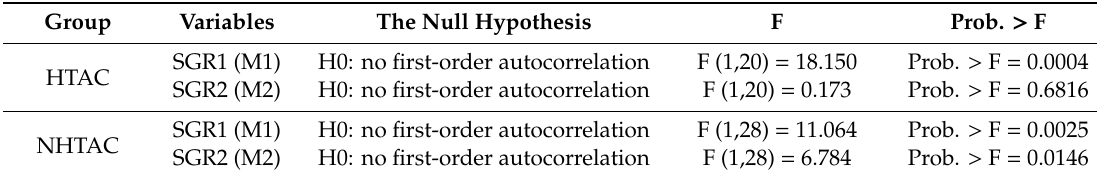
Table 7. Wooldridge test for autocorrelation in panel data.